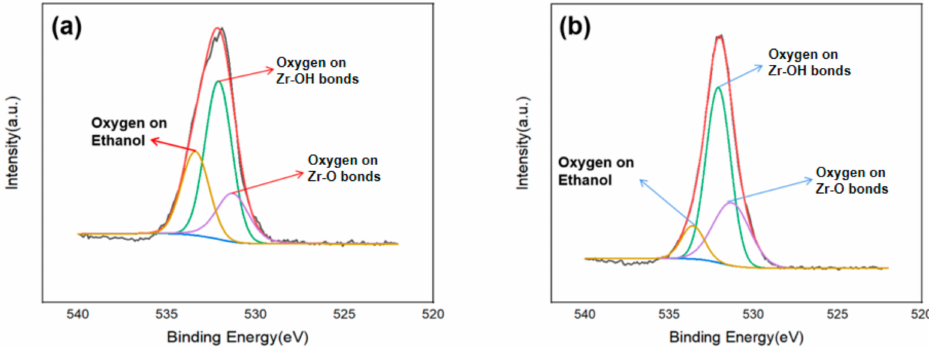
Figure 6. The XPS narrow-scan analysis of the oxygen atoms in the MOF-801 samples prepared in ( a ) 80 mL of ethanol, 20 mL of water, and ( b ) 20 mL of ethanol, 80 mL of